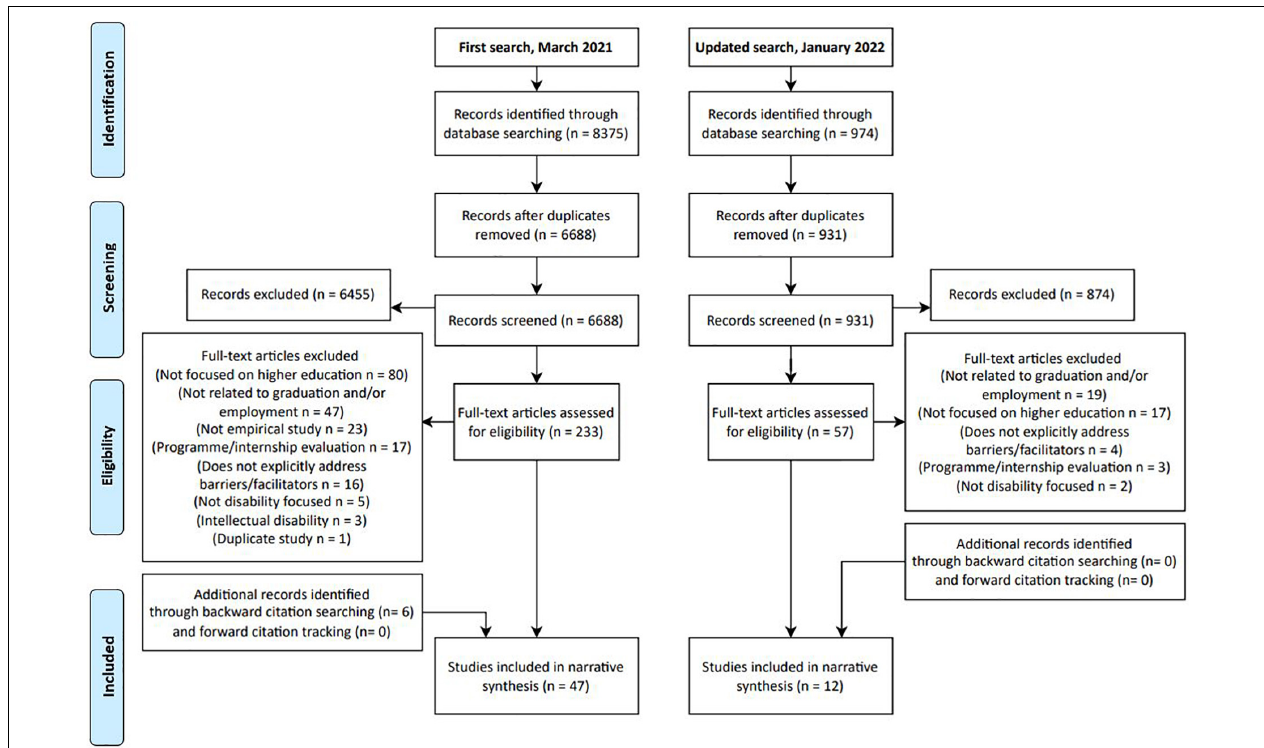
FIGURE 1 | PRISMA flow diagram of study selection process. Adapted with permission from Moher et al.